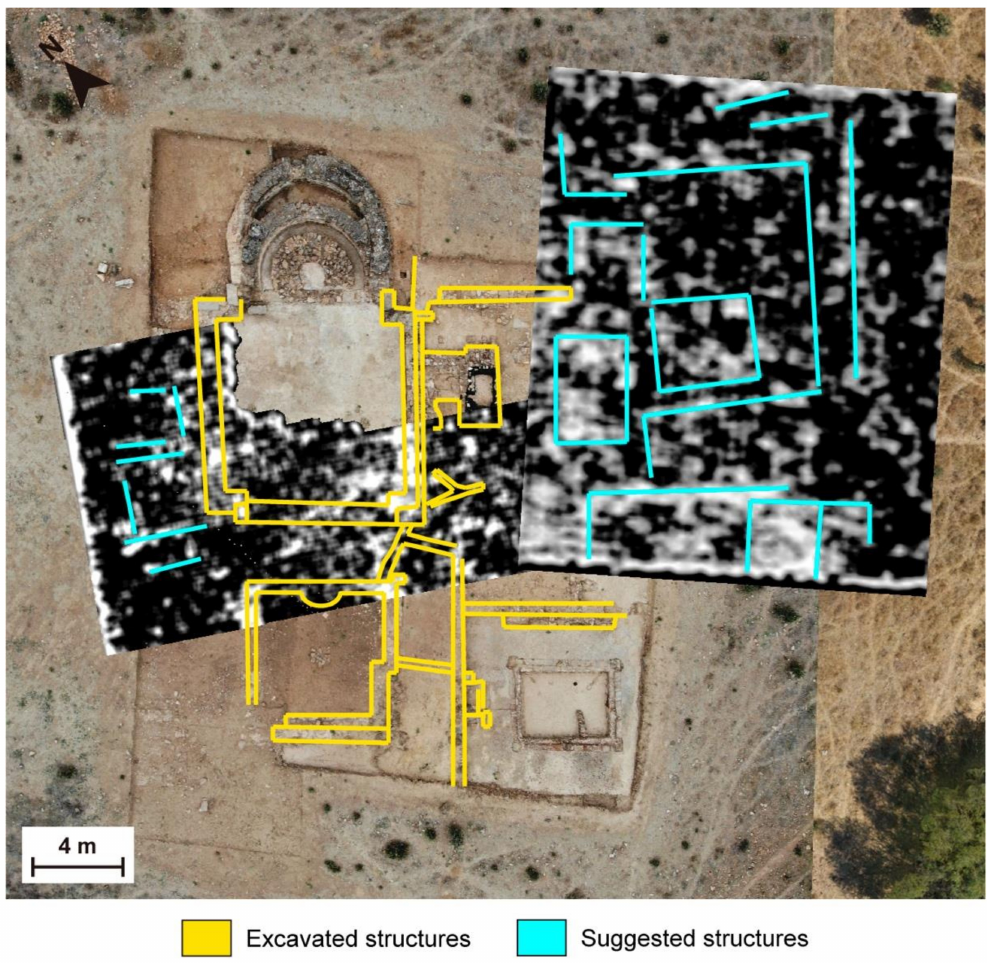
Figure 14. Cover surfaces from 2013 and 2015 GPR surveys after applying the INT-FFT algorithm. The outputs over an aerial orthophoto from Horta da Torre Site aid interpretation. In addition, we present a schematic representation of the visible structures (yellow lines) and the alignments obtained by geophysical prospecting (blue lines, unexcavated). The INT-FFT algorithm allows for a better observation of the reflection alignments, especially in the 2015 GPR